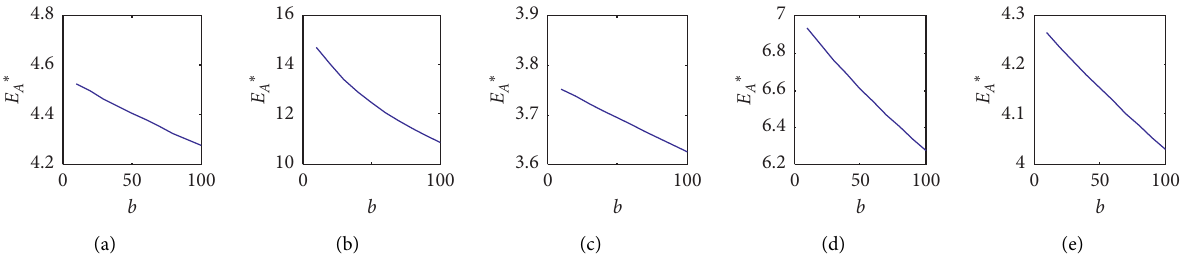
Figure 2: b versus E ∗ graph. (a) Problem 1. (b) Problem 2. (c) Problem 3. (d) Problem 4. (e) Problem 5. A